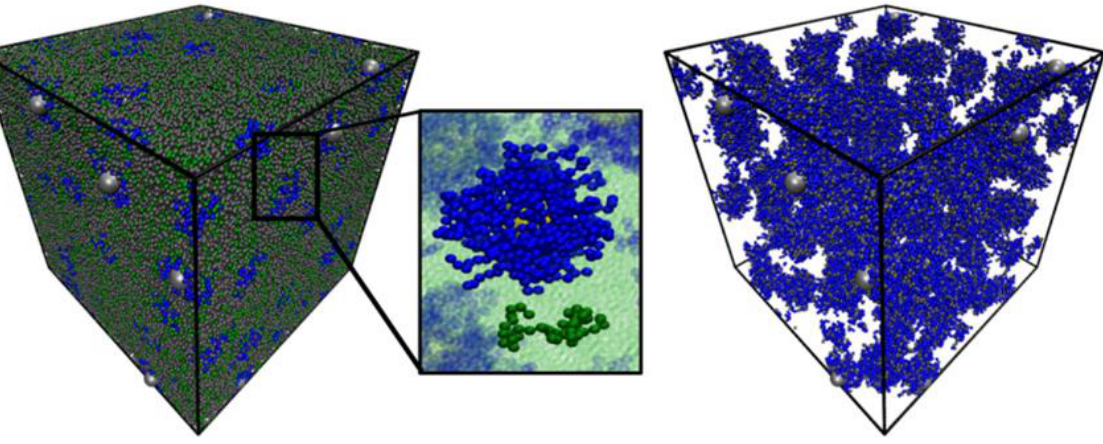
Figure 4. Simulation snapshots of polymer grafted nanoparticles (silver beads for particles and blue beads for grafted polymers) in an explicit homopolymer matrix (green beads). The left image shows all components of the simulation box; the center image shows representative chain configurations